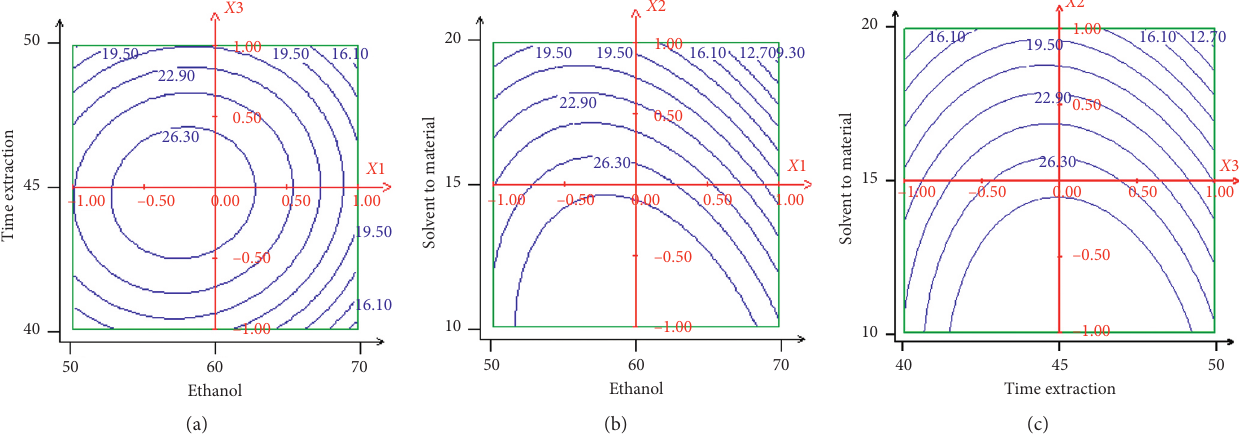
Figure 7: Contour plots for the effect of independent variables on extraction yield. (a) Contour plot graph showing interaction between extraction time ( X 3) and ethanol concentration ( X 1); (b) contour plot graph showing interaction between solvent-to-material ratio ( X 2) and ethanol concentration ( X 1); (c) contour plot graph showing interaction between extraction time ( X 3) and solvent-to-material ratio ( X 2).